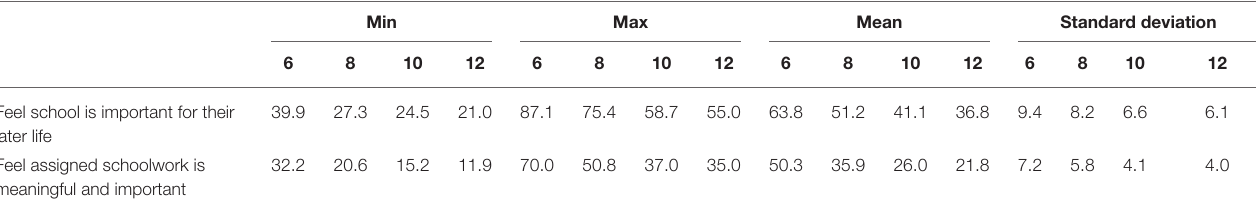
TABLE 1 | Table showing the minimum, maximum, and mean values with standard deviation, for each of the questions in the PAYS survey and each grade for the state of Pennsylvania as a whole. Min Max Mean Standard